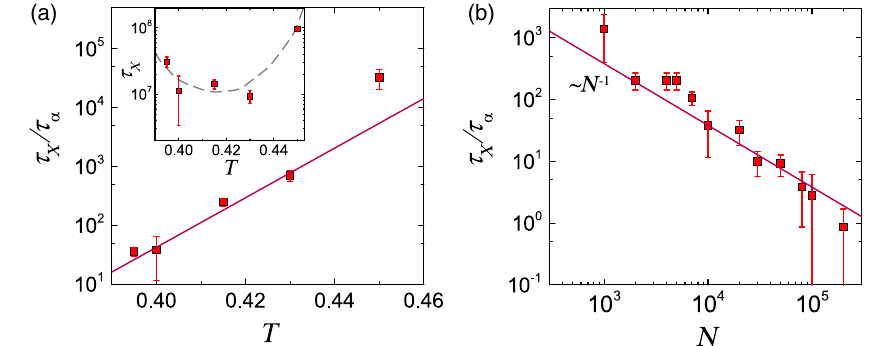
FIG. 3. Nucleation times τ X with respect to temperature and system size in the KA mixture. (a) Nucleation time scaled by the relaxation time τ α as a function of temperature T at N ¼ 10 000 . Line is a fit to τ X = τ α ∼ e AT , with A ≈ 97 . Inset: Nonscaled nucleation times τ X with a curve to guide the eye (dashed line). (b) Nucleation times as a function of system size at T ¼ 0 . 40 . Line represents expected 1 =N scaling for τ X in the case of a constant nucleation rate. We determine τ X as described in the